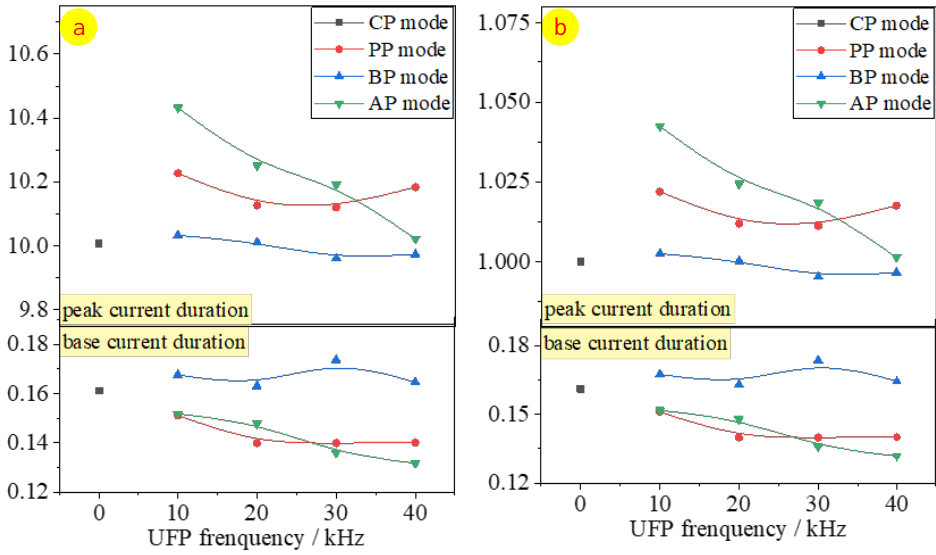
Figure 2. The curve of axial arc force ( a ) and plasma jet force quantized value ( b ).